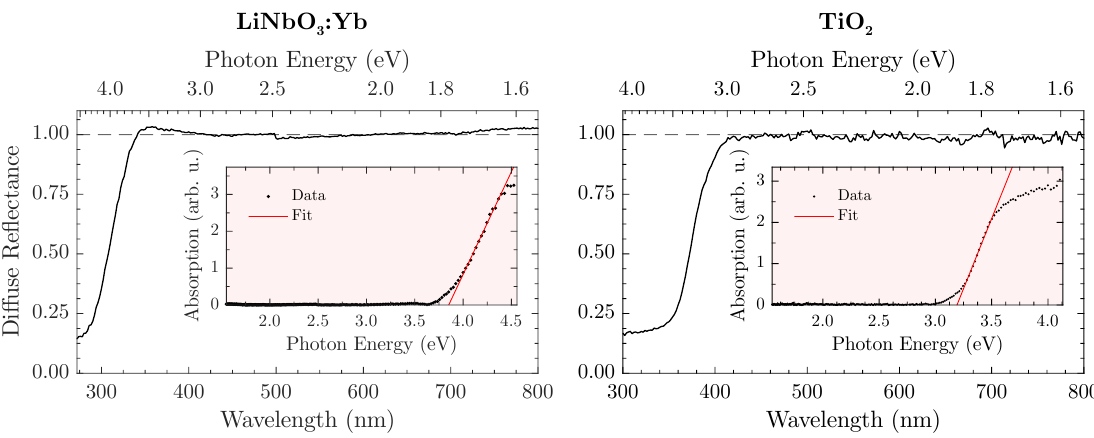
Figure 3. Diffuse reflectance spectra of LiNbO 3 :Yb- ( left ) and TiO 2 -nanopowder ( right ). Insets are corresponding Tauc-plots for determining the indirect allowed band edge. Further information is found in the accompanying